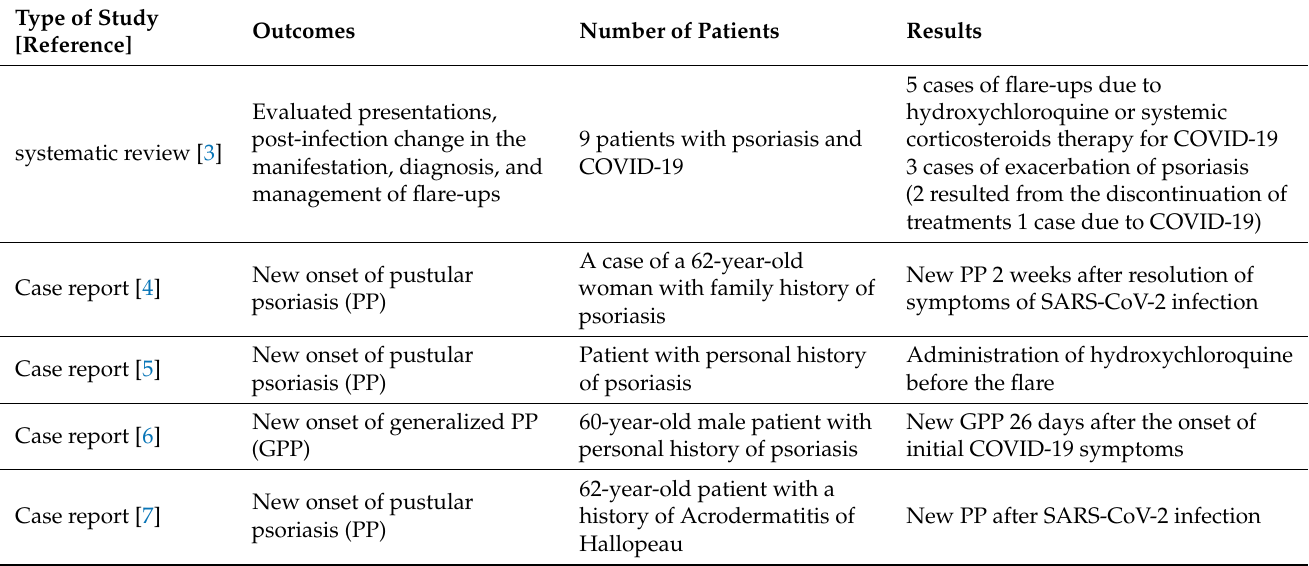
Table 1. Impact of SARS-CoV-2 infection on psoriasis clinical